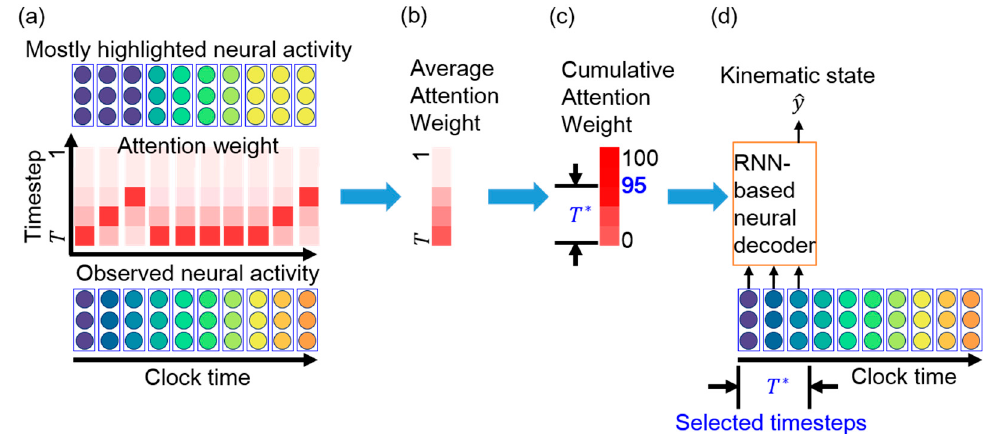
Figure 3. Schematic of essential timestep selection using attention weights. ( a ) Observed neural activity (bottom) and attention weights (middle) across clock time. The mostly highlighted neural activity at each time bin (top) is obtained from the attention weight. For example, the mostly highlighted neural activity at the first time bin is the neural activity at timestep 𝑇 , which is observed at the first time bin. The mostly highlighted neural activity at the second time bin is the neural activity at timestep 𝑇 − 1 , which is identical to the neural activity observed at the first time bin. Therefore, the mostly highlighted neural activities at the first three time bins are identical to the observed neural activity at the first time bin. ( b ) Average attention weight across clock time. ( c ) Cumulative attention weight over the timestep. The most recent 𝑇 ∗ consecutive timesteps are essential for neural decoding. ( d ) The RNN-based neural decoder is retrained with 𝑇 ∗ timesteps.